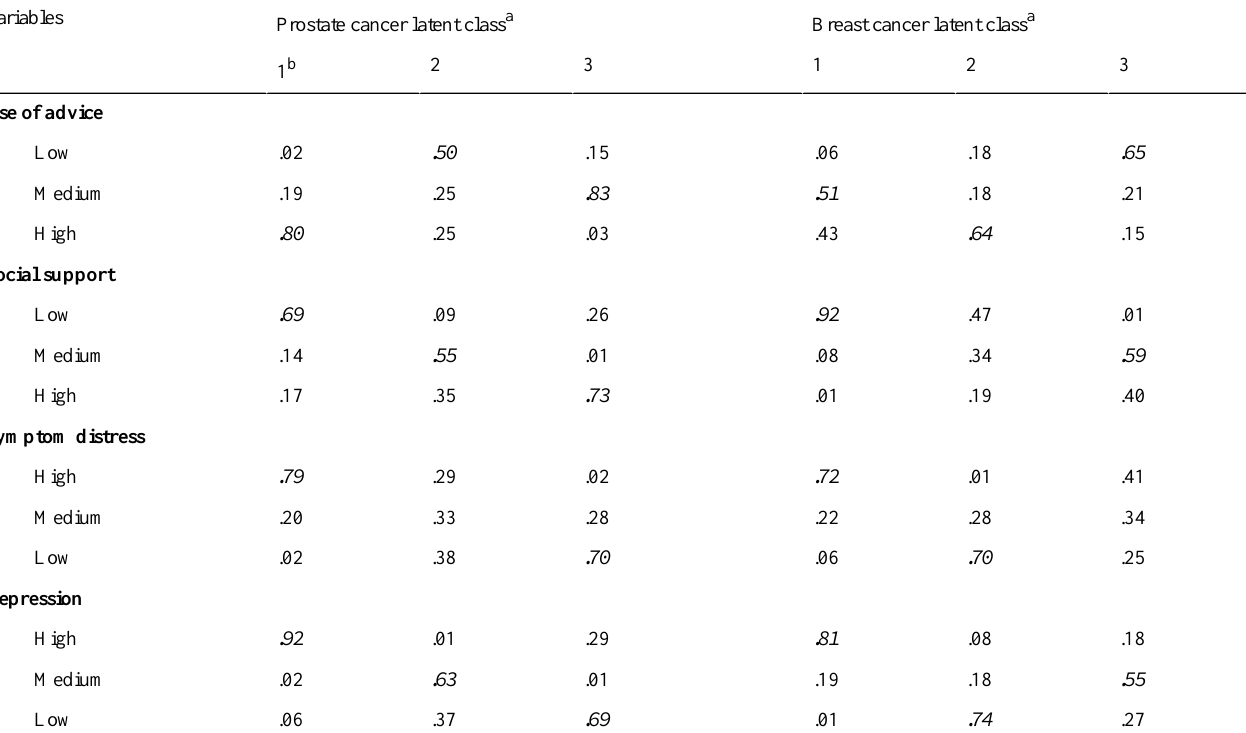
Table 8. Use of the advice component in WebChoice (in minutes). Latent class model, association with levels of social support, symptom distress, and depression. The numbers represent item probabilities. All models were stratified by diagnosis and adjusted for age at